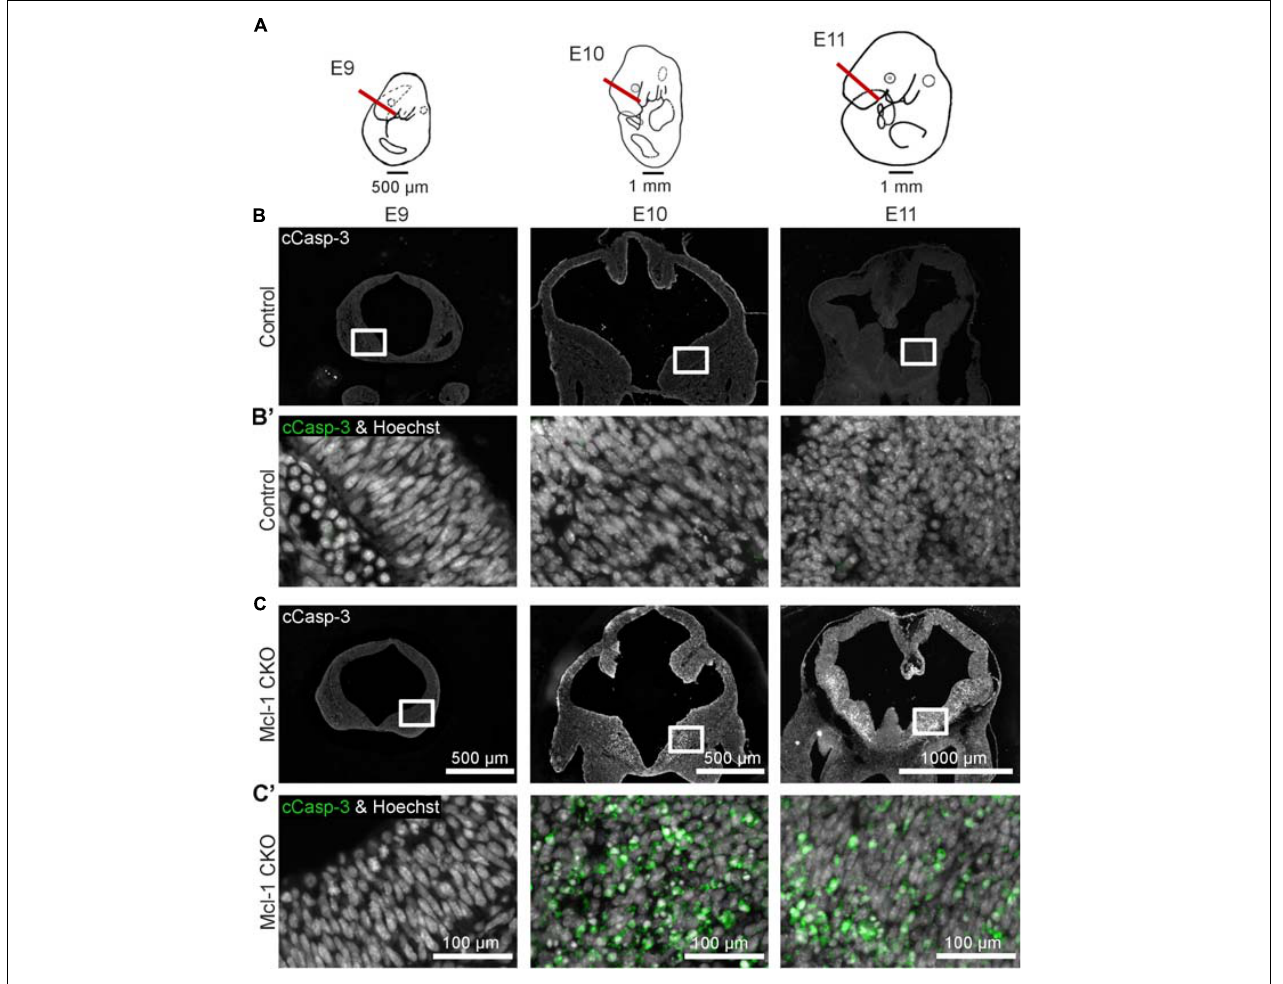
FIGURE 2 | Conditional deletion of Mcl-1 results in apoptosis beginning at E10 in the forebrain. (A) Line drawings of E9-E11 embryos demonstrating where coronal sections from developing forebrain were collected. (B) Representative images of coronal sections through the forebrains of CTL embryos at E9 ( n = 3), E10 ( n = 2) and E11 ( n = 4) immunostained for cCasp-3 (white). (B (cid:48) ) Higher magnification images of boxed areas in B double-labeled for cCasp-3 (green) and Hoechst (white). (C) Representative images of coronal sections through the forebrains of Mcl-1 CKO embryos at E9 ( n = 3), E10 ( n = 2) and E11 ( n = 4) immunostained for cCasp-3 (white). (C (cid:48) ) Higher magnification images of boxed areas in C double-labeled for cCasp-3 (green) and Hoechst (white). Arrows indicate apoptotic